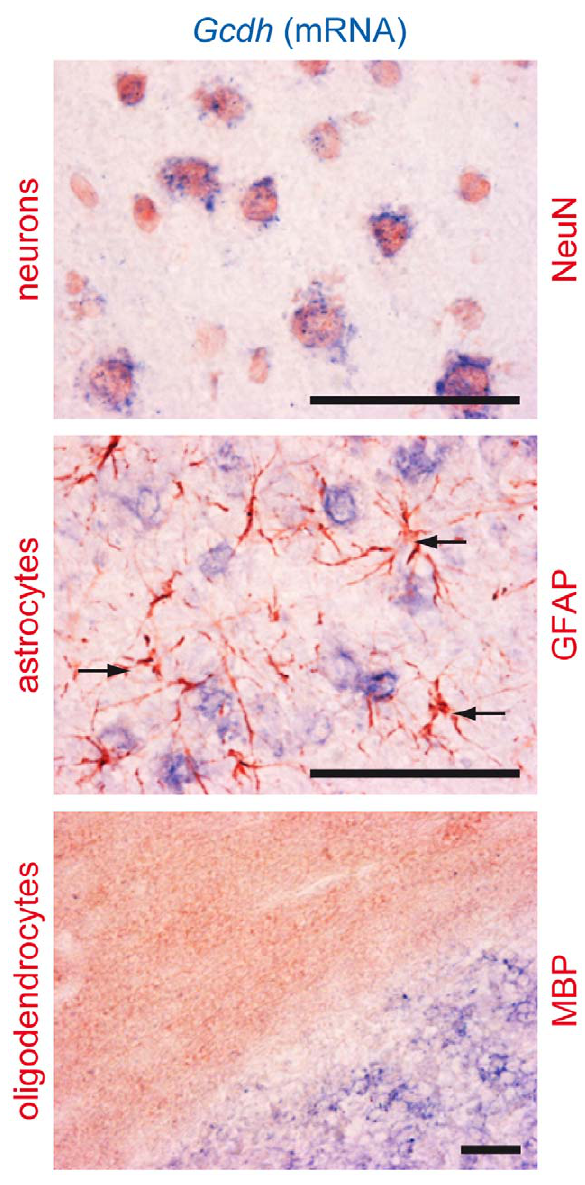
Figure 7. Expression of GCDH in neurons, astrocytes and oligodendrocytes. In situ hybridization for GCDH mRNA in adult rat brain (16 m m cryosections), co-labeled by immunohistochemistry for specific markers of neurons (NeuN), astrocytes (GFAP) or oligoden- drocytes (MBP). Top and central panels show expression of GCDH mRNA (blue signal) in cortical neurons (top; NeuN, red signal), while GCDH mRNA could not be detected in cortical astrocytes (central; GFAP, red signal, arrows pointing at astrocytic cell bodies). Bottom panel shows GCDH mRNA (blue signal) in granular neurons of cerebellum, while GCDH mRNA appears absent from adjacent oligodendrocytes in white matter of cerebellum (bottom; MBP, red signal). Scale bar: 100 m m.